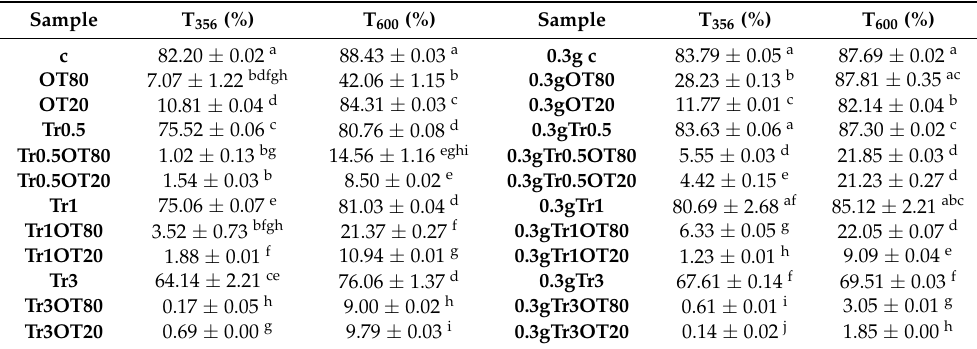
Table 2. Transmittance of films.